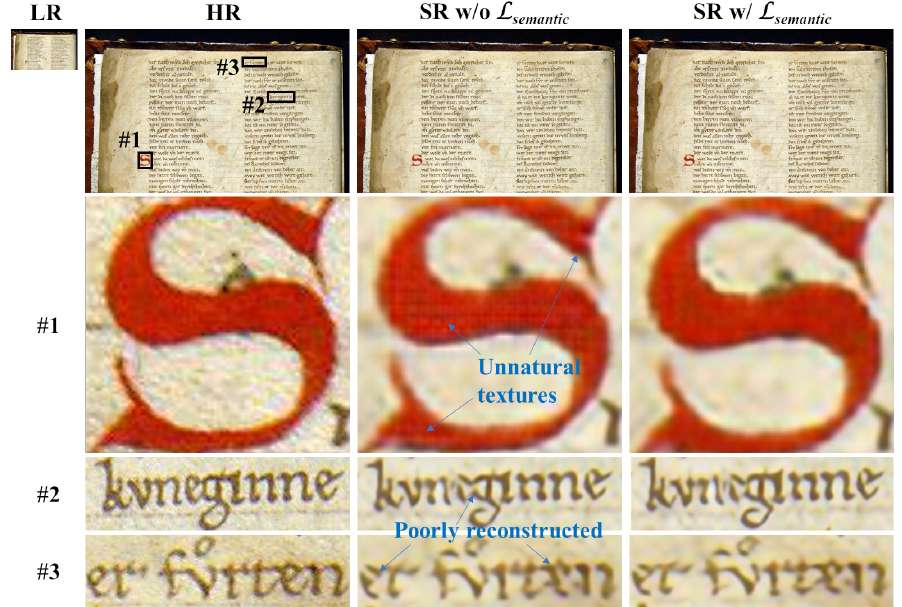
Figure 3. Visual comparison (case 1) of text SR images with and without the semantic loss between training using OBCC-OCR. The images were enlarged to improve visibility. Without semantic loss, the letters either have unnatural and unpleasant textures or are poorly reconstructed.